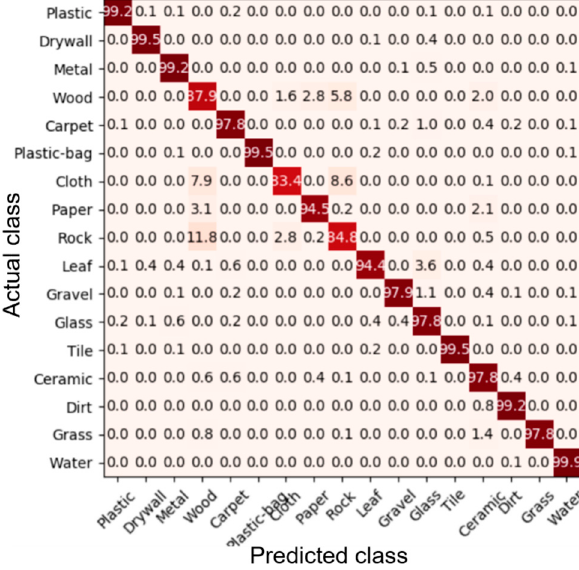
Figure 5. Confusion matrix of material estimation.